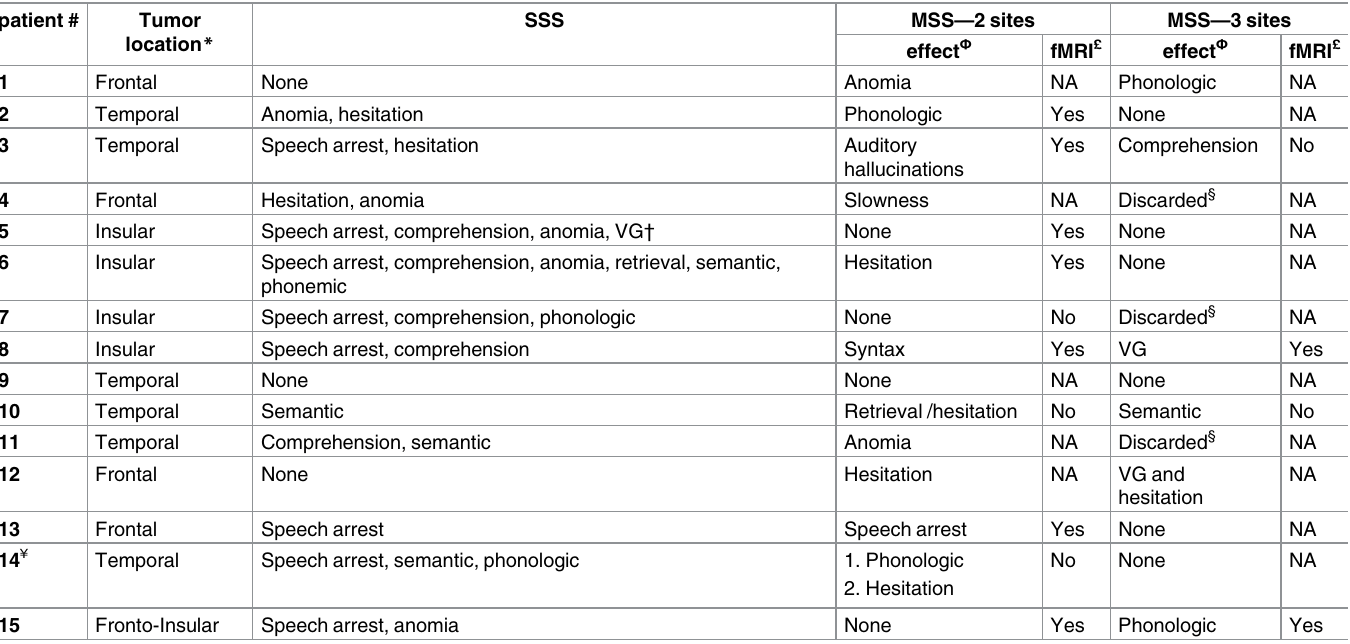
Table 2. Single-, two- and three- site stimulation functional